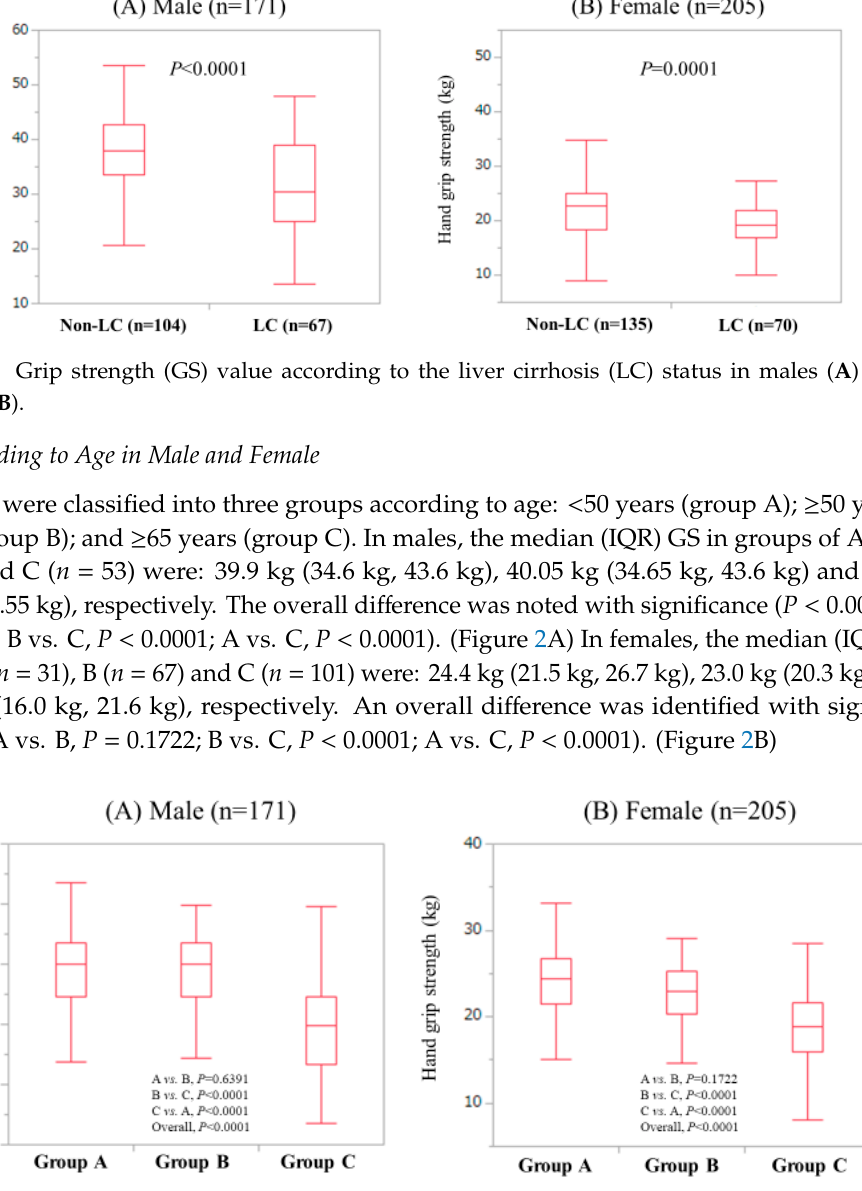
Figure 2. GS value according to the LC status in male ( A ) and female ( B ); Group A indicates patients 50 or less than 50 years; Group B indicates patients more than 50 years and 65 or less than 65 years; Group C indicates patients more than 65 years.